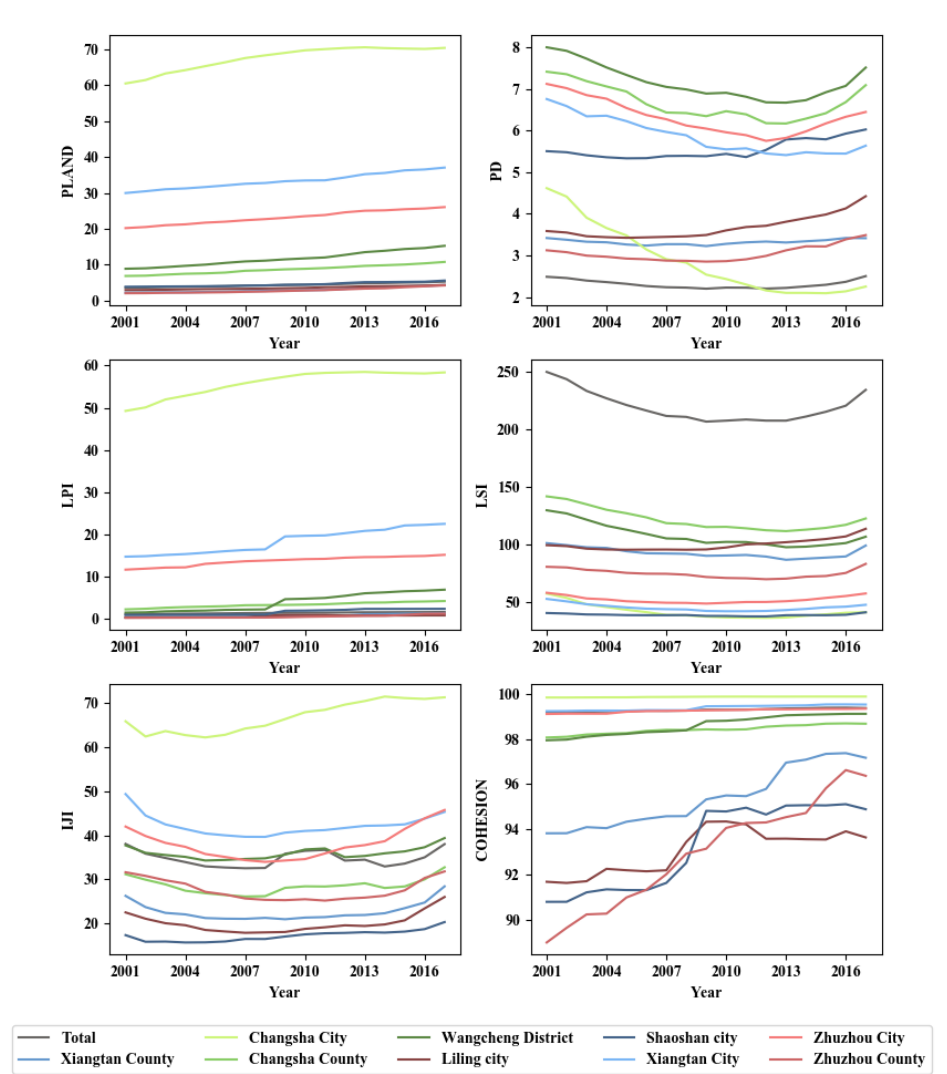
Figure 8. Dynamics of the landscape metrics for the impervious surface in CZTUA from 2001 to 2017.